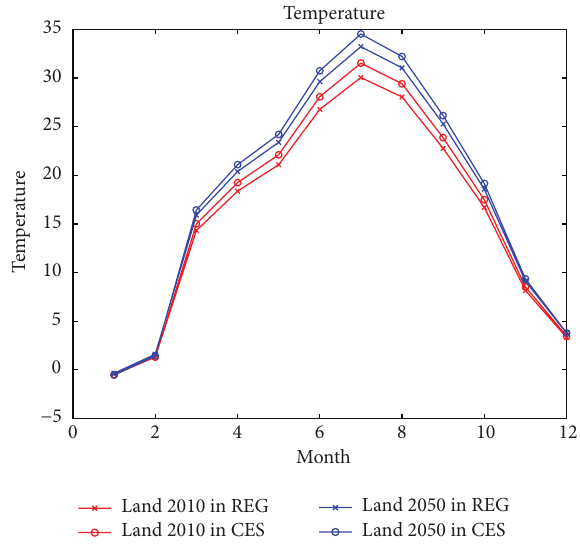
Figure 5: Simulated monthly average temperature in Southern- Jiangsu under different scenarios (unit: ∘ C). Land 2010 in REG sce- nario and Land 2010 in CES scenario represent the monthly average temperature simulated with the LUCC data in 2010 under the REG scenario and CES scenario as the underlying data, respectively. Land 2050 in REG scenario and Land 2050 in CES scenario refer to that in